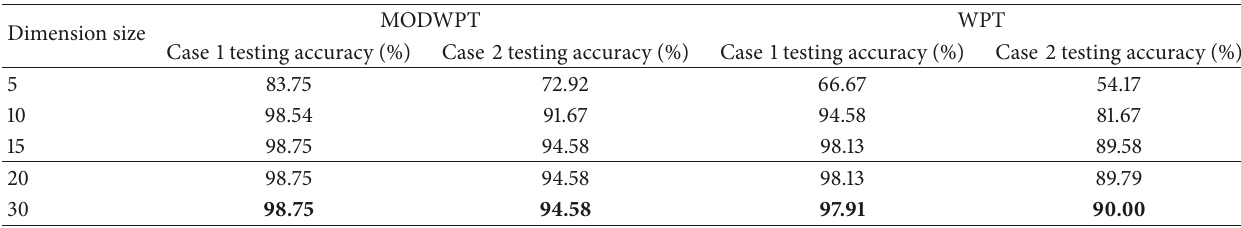
Table 7: Bearing fault diagnosis results obtained by OFS-SNPEL-SVM.